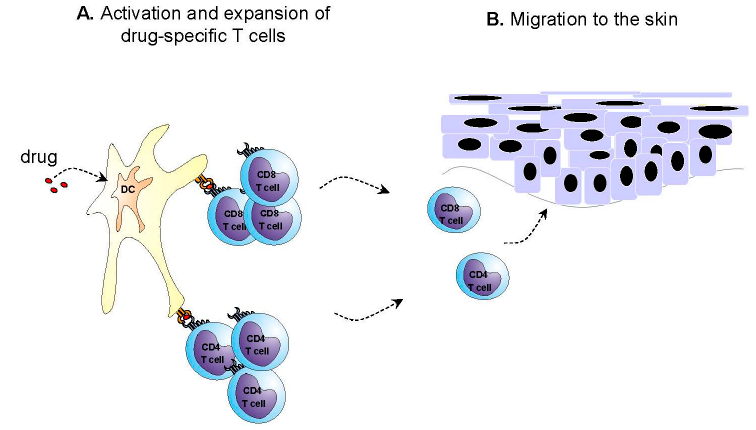
Figure 1. Cont. Figure 1.